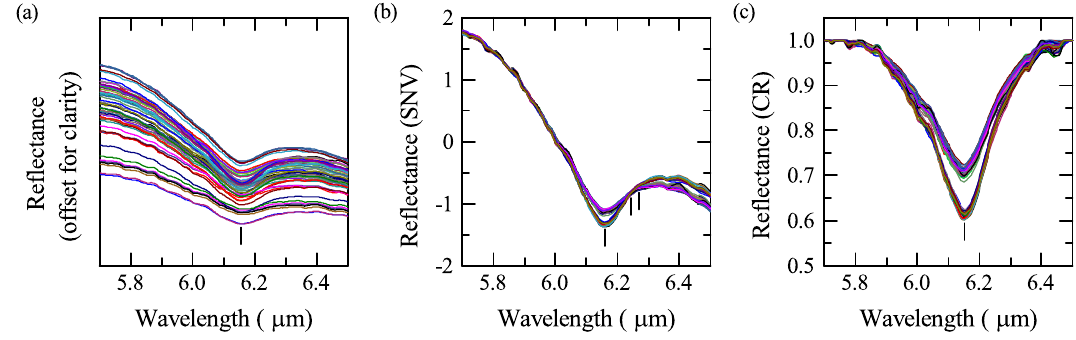
Figure 5. ( a ) Raw; ( b ) SNV; and ( c ) CR processed infrared spectra of calcined kaolin in the 5.7 to 6.5µm region. The markers indicate the center of the wavelength of the water feature at 6.15µm and the right shoulders in the SNV spectra at 6.24 and